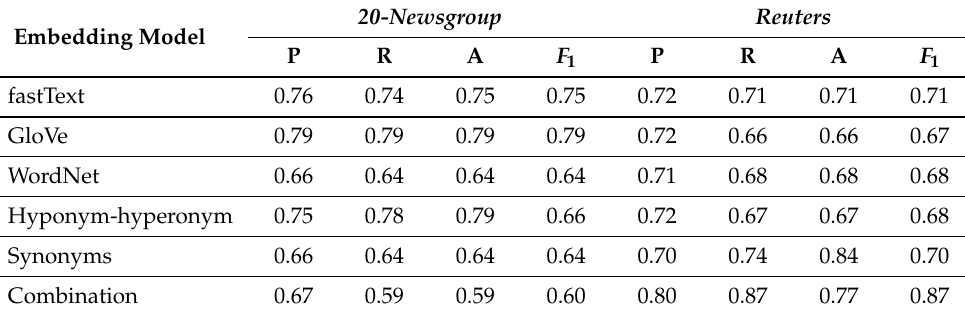
Table 7. Results obtained with the CNN and the proposed models. Embedding